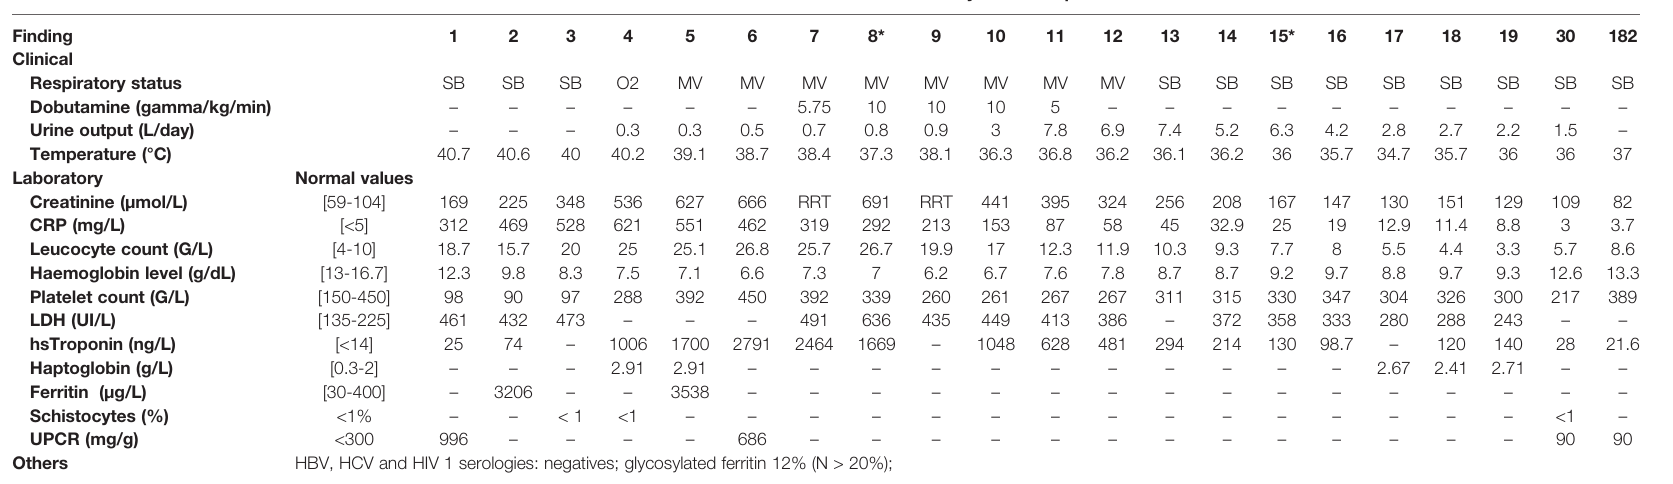
TABLE 1 | Clinical and laboratory fi